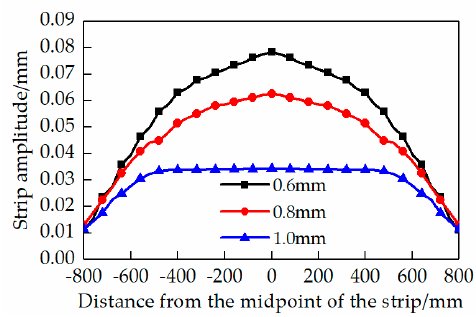
Figure 16. Amplitude distribution of different thicknesses.